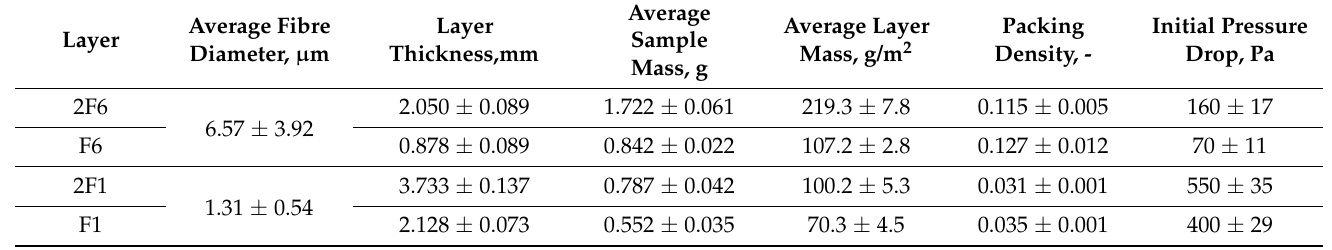
Table 2. Filter properties.